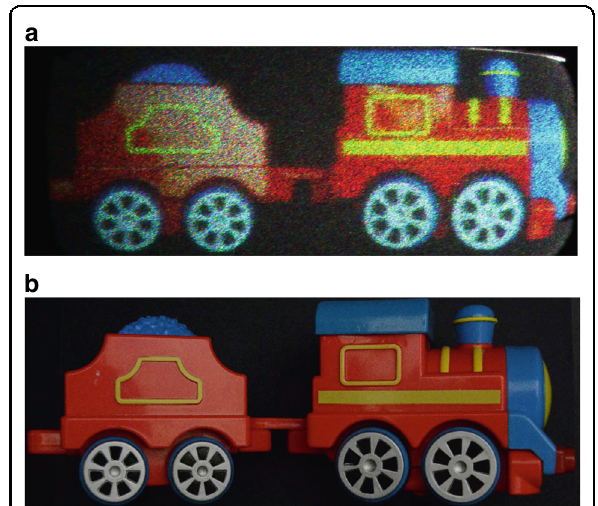
Fig. 6 Reconstructed holographic images of a toy train with holobricks. a Reconstructed holographic images, and b original image captured by a